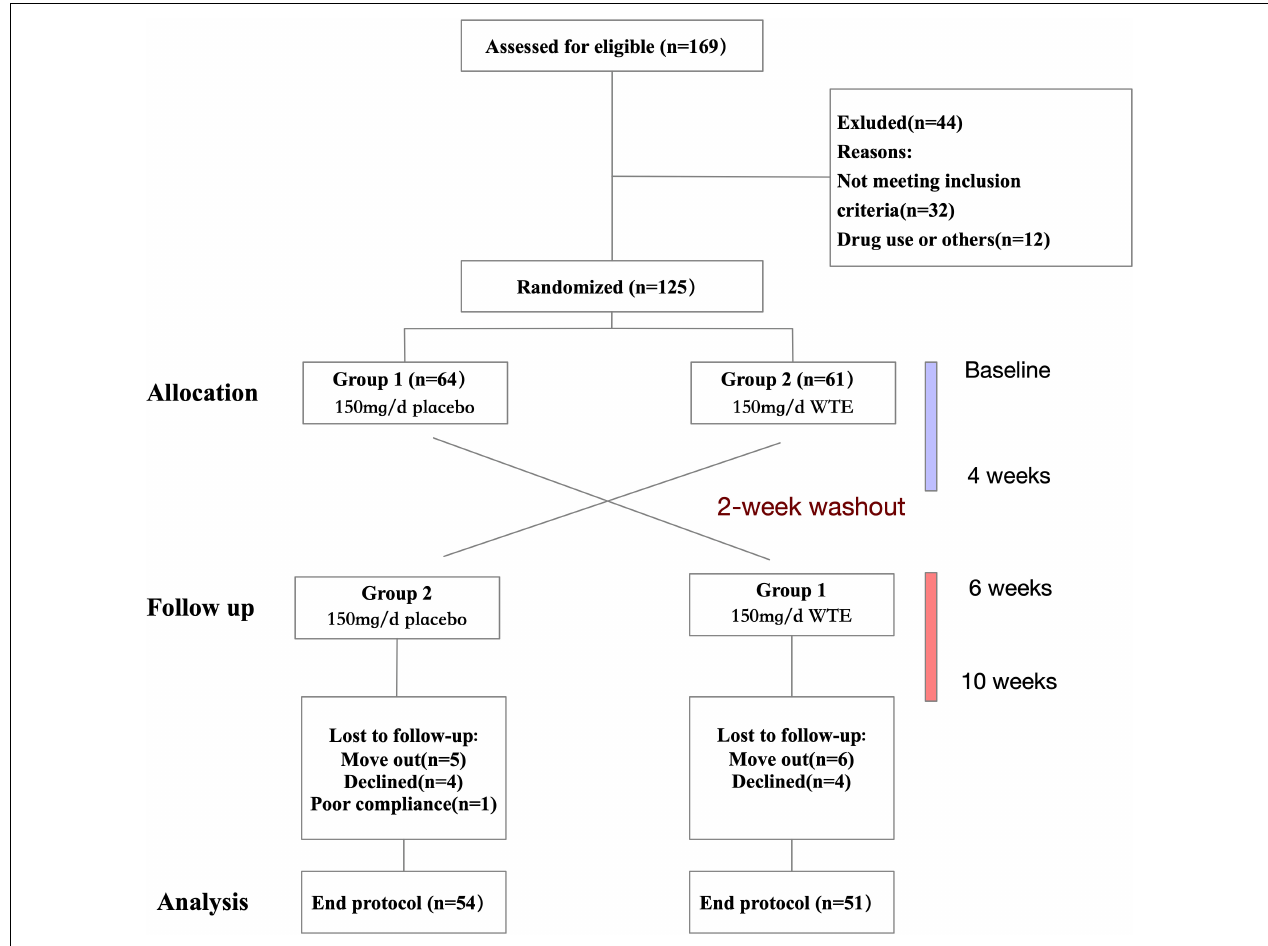
FIGURE 1 | Flow diagram of the study population.